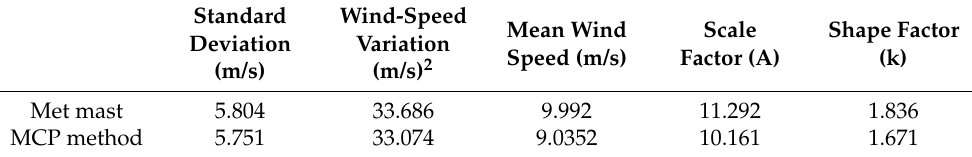
Table 1. Key parameters of wind distribution from met mast and